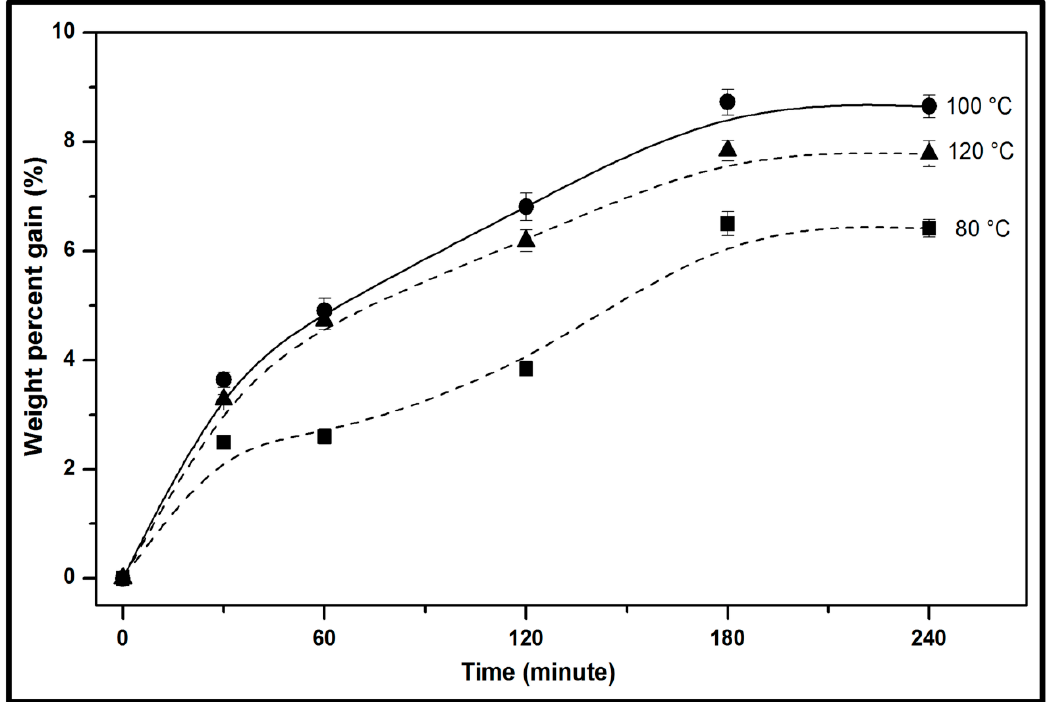
Figure 2. Weight percent gain of modified nonwoven kenaf fibre with different reaction temperature and different retention time.